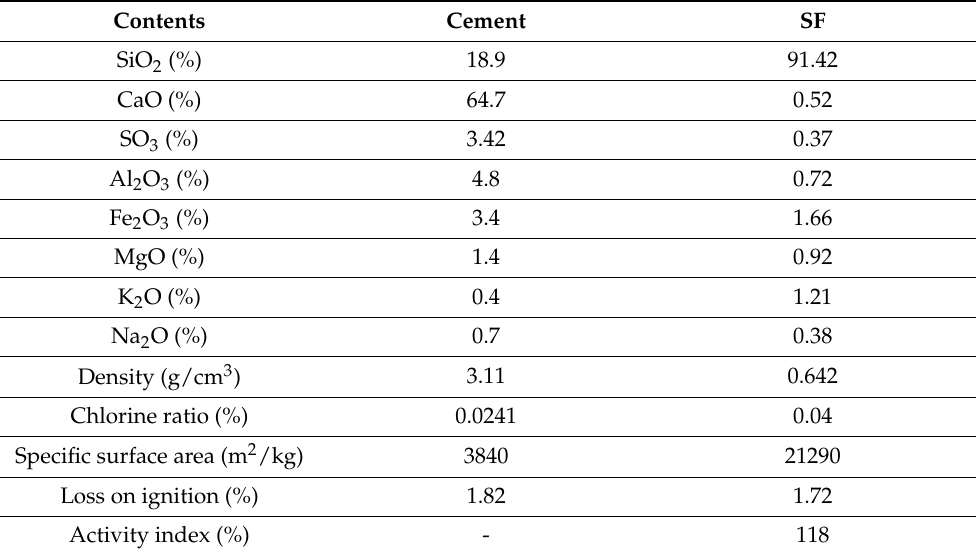
Table 1. Properties of cement and silica fume.